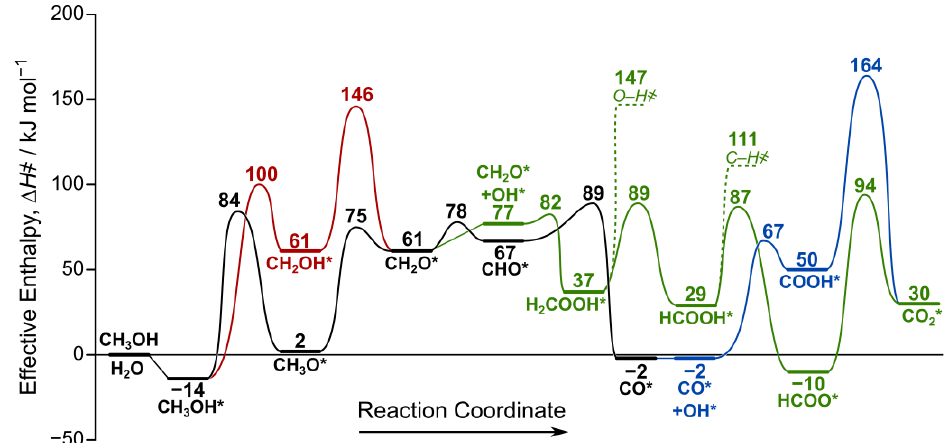
Figure 2. DFT-predicted reaction enthalpy diagram for methanol decomposition (black and red), methanol steam reforming (green), and the water – gas shift reaction (blue) pathways. Energies are calculated using Equation (5) at 573 K and each platform represents the most stable adsorption state for each intermediate discussed in Section 2.1. H atoms removed are desorbed from the surface as H 2 (g) and are not displayed for clarity. Dashed lines show barriers for unfavorable bond activation.